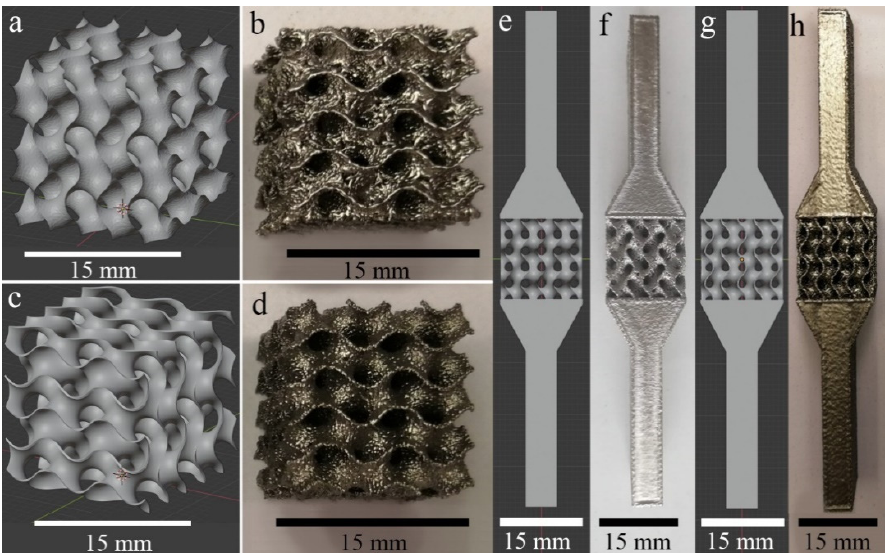
Figure 1. Samples for compression tests: ( a ) 3D model with zero thickness; ( b ) WT specimen; ( c ) 3D model with 200 µm thickness; ( d ) MT specimen. Samples for tension tests: ( e ) 3D model with zero thickness; ( f ) WT specimen; ( g ) 3D model with 200 µm thickness; ( h ) MT specimen.